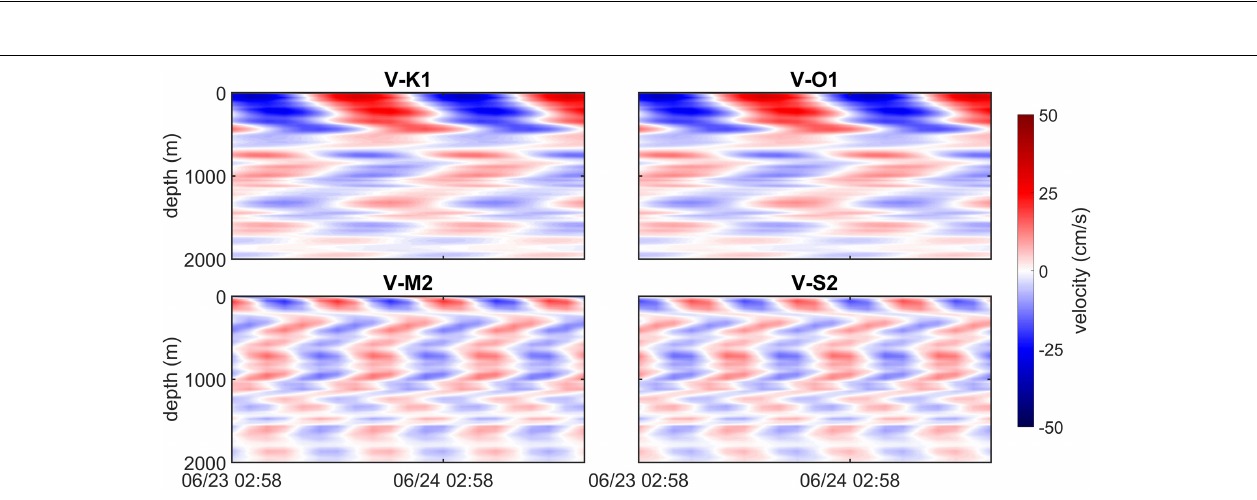
FIGURE 5 | (A–C) Internal tide components acquired from the deep mooring located on the northern slope of the seamount. (D–F) Internal tide components acquired from the deep mooring located on the southern slope of the seamount.